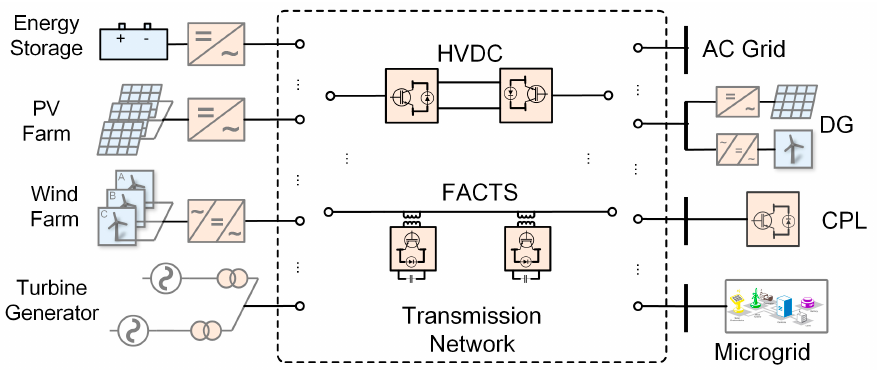
Figure 1. Block schematic of a typical power system with high penetration of renewable energy.